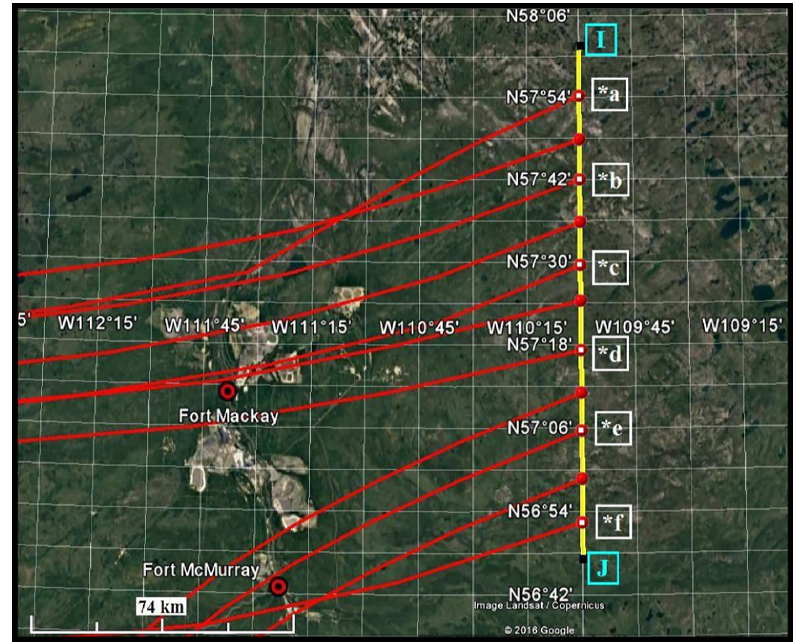
Figure 8. The flight segment I–J on 22 August 2013 is represented by the yellow line. Point “I” represents the starting position of the flight leg and point “J” is the ending position. Backward air trajectories initiated from an altitude of 1000ma.s.l. on 22 August 2013 at 14:00 local time (UTC − 6h) are shown in red and marked by the points *a to *f.